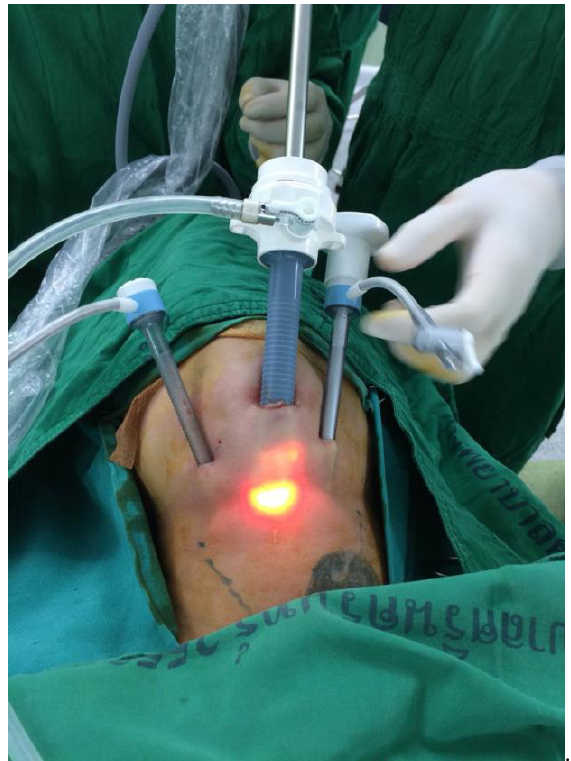
Figure 1. Submental endoscopic thyroidectomy.